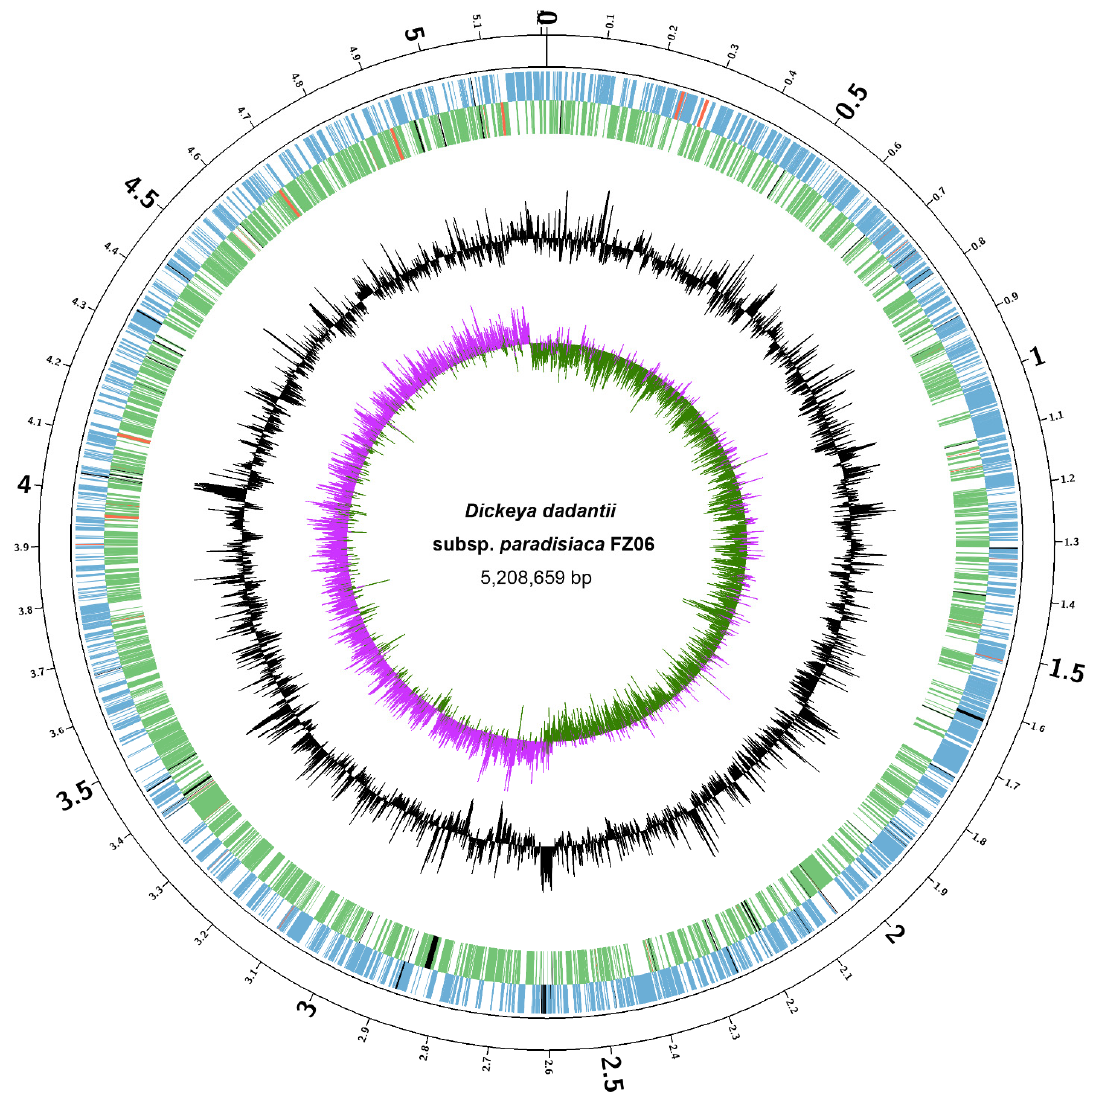
Figure 3. Circular chromosome map of D. dadantii subsp. paradisiaca FZ06. The circles (from outside to inside) represent features of the positive strand, showing coding sequence (CDS) (blue), rRNA (red), and pseudogenes (black); features of the negative strand, showing CDS (green), rRNA (red), and pseudogenes (black); GC content; and GC-skew (pink and green indicate values higher and lower than the mean value, respectively). Table 2. Genomic features of strains FZ06 and MS2.